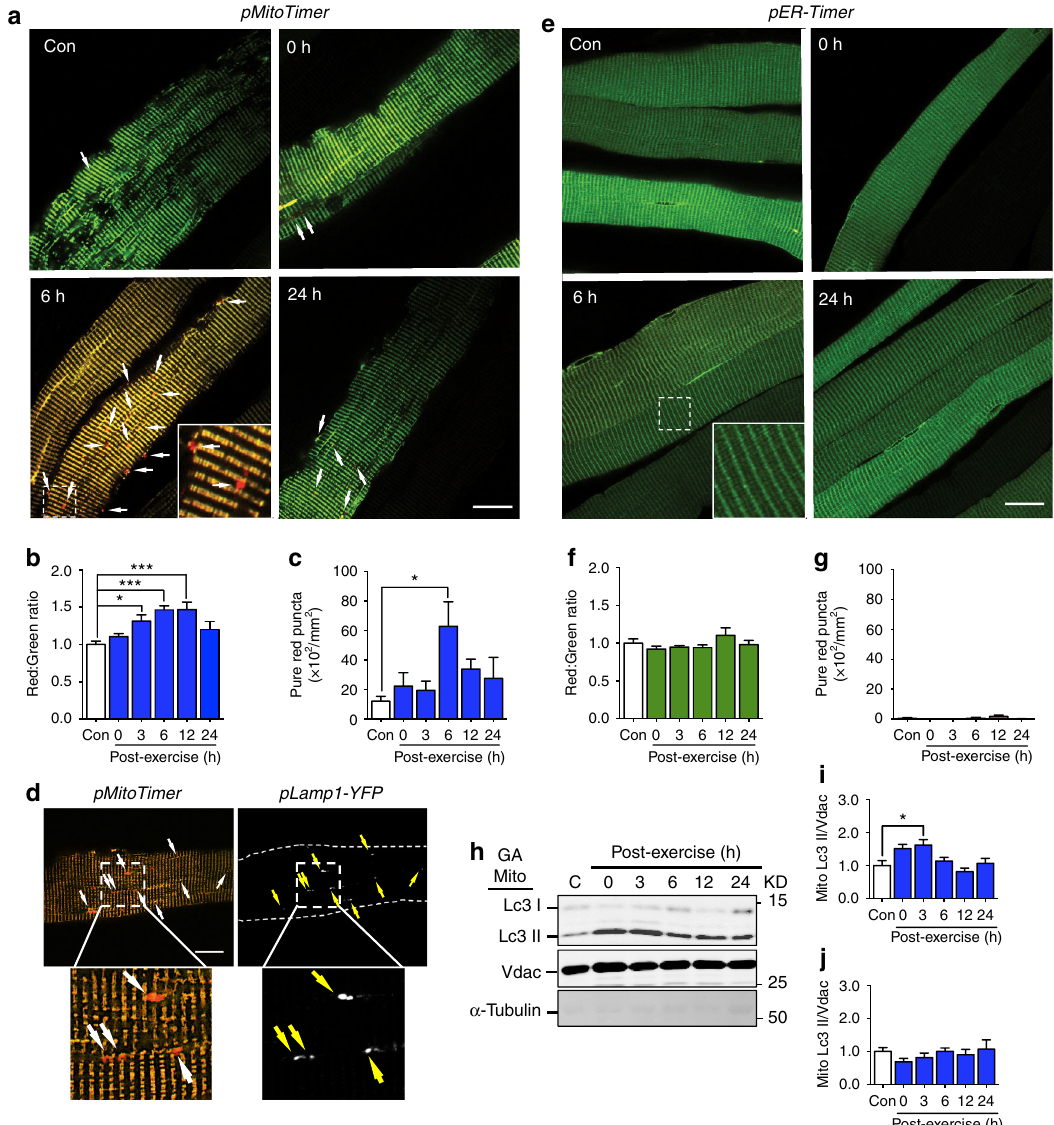
Fig. 1 Acute exercise causes transient mitochondrial stress and mitophagy during recovery. a Representative images of C57BL/6J mouse (10 – 12 weeks) FDB fi bers transfected with pMitoTimer at time points following acute exercise. Images are merged red and green channels. Scale bar = 20 µ m. See also Supplementary Fig. 1. b Quanti fi cation of MitoTimer red : green fl uorescence intensity and c pure red puncta in n = 7 – 10 mice per time point. d Representative images of mouse FDB fi bers co-transfected with pMitoTimer and pLamp1-YFP at 6 h post exercise illustrating that MitoTimer pure red puncta co-localized with Lamp1-YFP puncta. e Representative images of contralateral mouse FDB fi bers transfected with pER-Timer at time points following acute exercise. Scale bar = 20 µ m. See also Supplementary Fig. 1. f Quanti fi cation of ER-Timer red : green fl uorescence intensity and g pure red puncta in n = 5 – 6 mice per time point. h Representative western blot for Lc3 in mitochondria enriched skeletal muscle fractions. Upper band corresponds to Lc3-I and lower band to Lc3-II, with Vdac as the loading control, at time points following acute exercise. i Quanti fi cation of Lc3-II and j Lc3-I protein abundance relative to Vdac, n = 5. See also Supplementary Fig. 5. Data presented as mean ± standard error of the mean. Results of one-way ANOVAs are * p < 0.05, ** p < 0.01, and *** p < 0.001. F = 8.07 ( b ), F = 3.10 ( c ), F = 1.29 ( f ), F = 0.91 ( g ), F = 5.15 ( i ), F = 0.74 ( j ). DF = 5 MitoTimer and ER-Timer pure red puncta c , g were